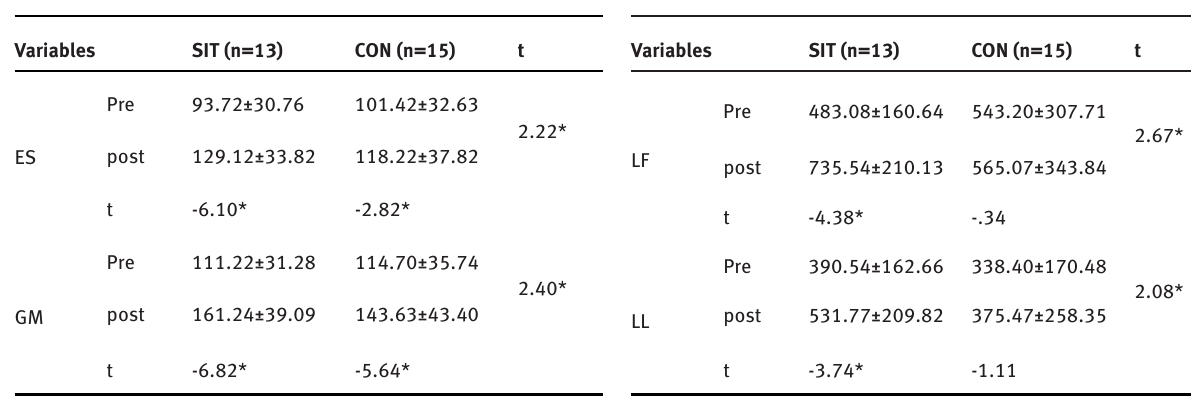
Table 3: Comparison of pre and post limit of stability in the SIT and CON